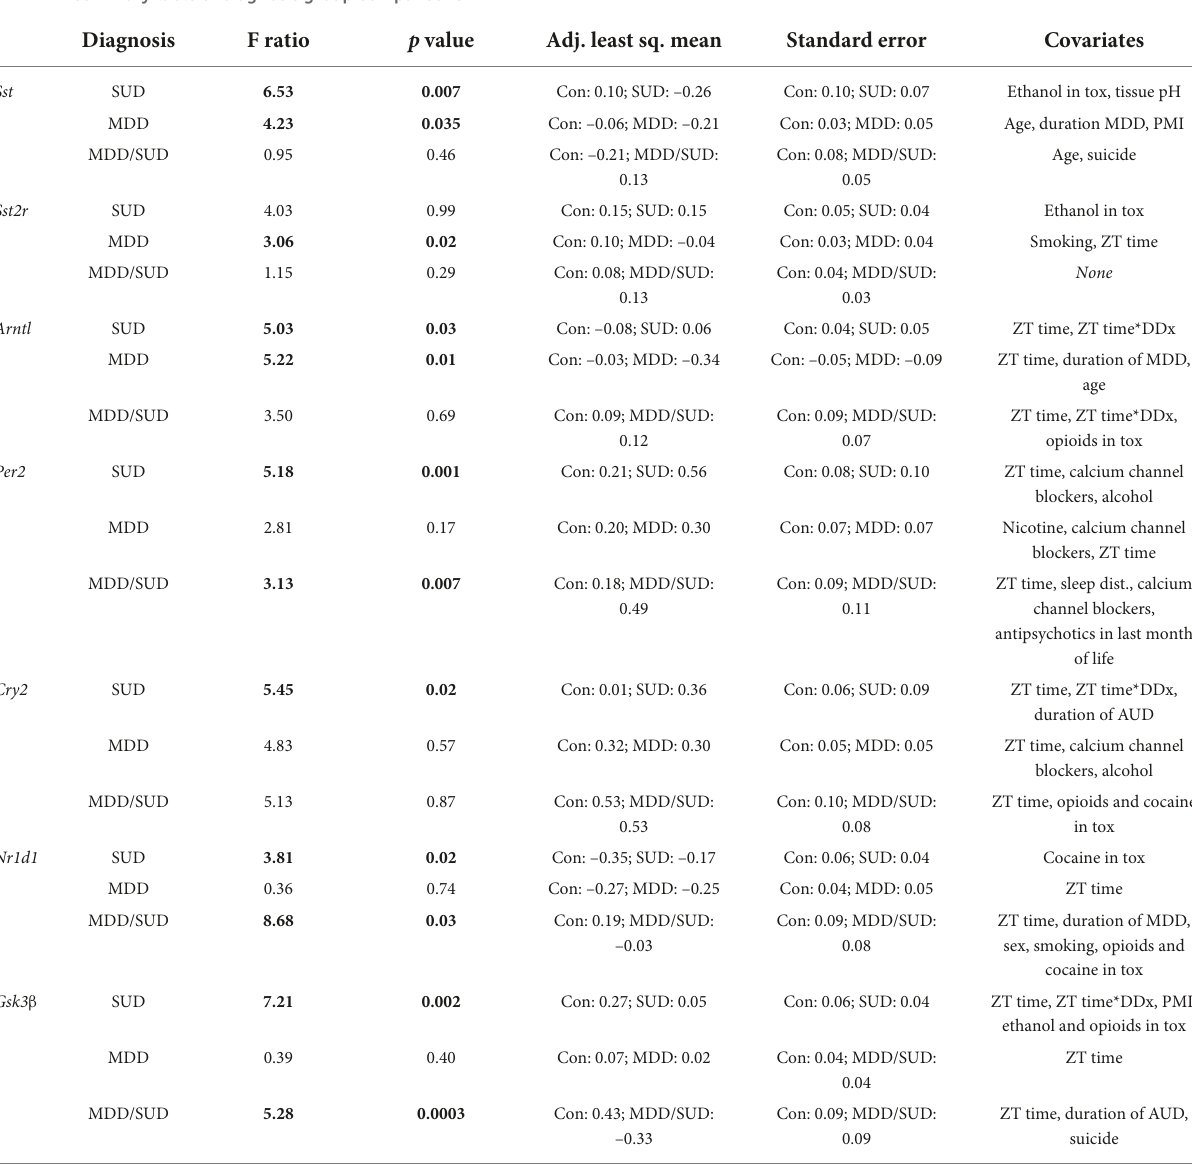
TABLE 2 Summary table of diagnosis group